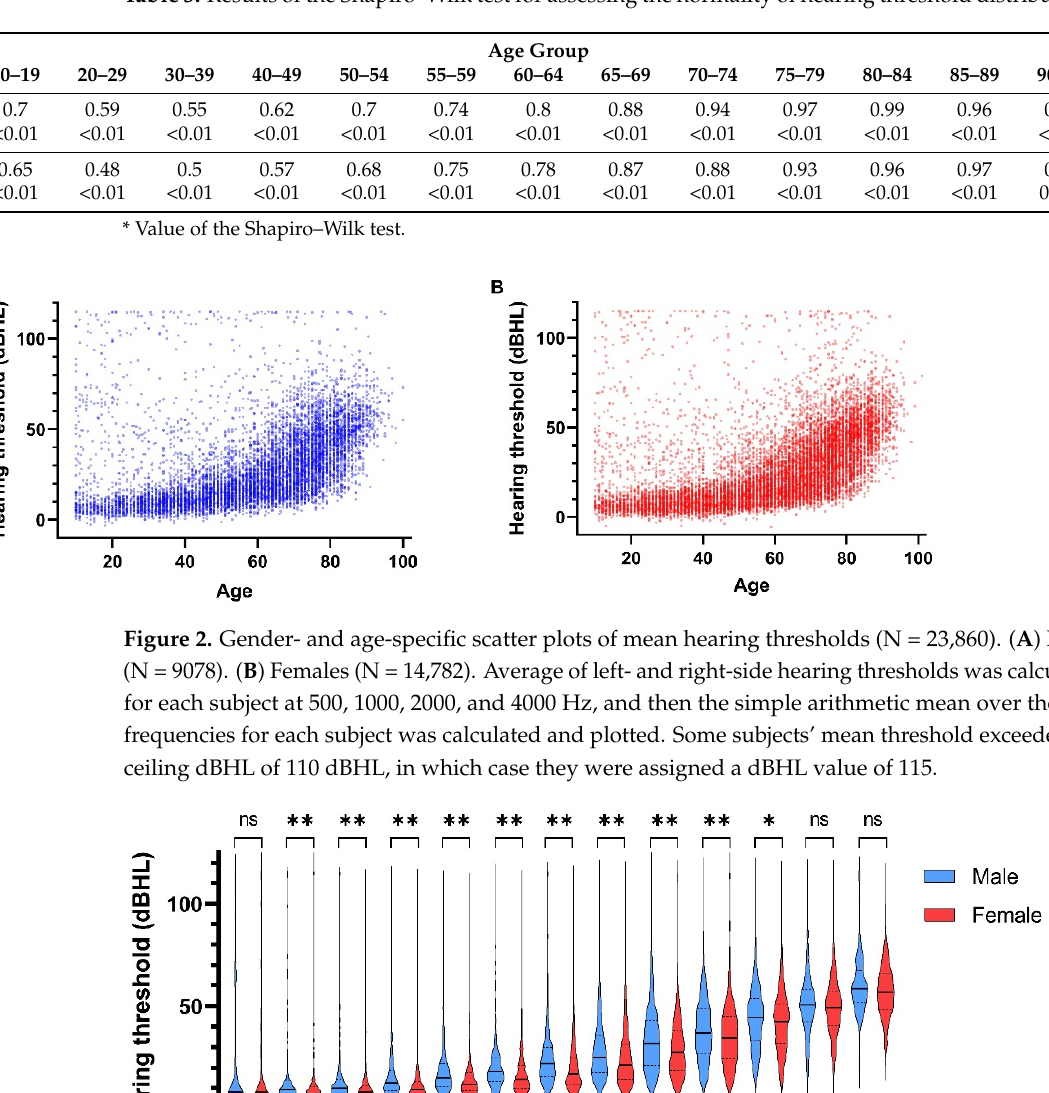
Table 3. Results of the Shapiro–Wilk test for assessing the normality of hearing threshold distribu- tions.